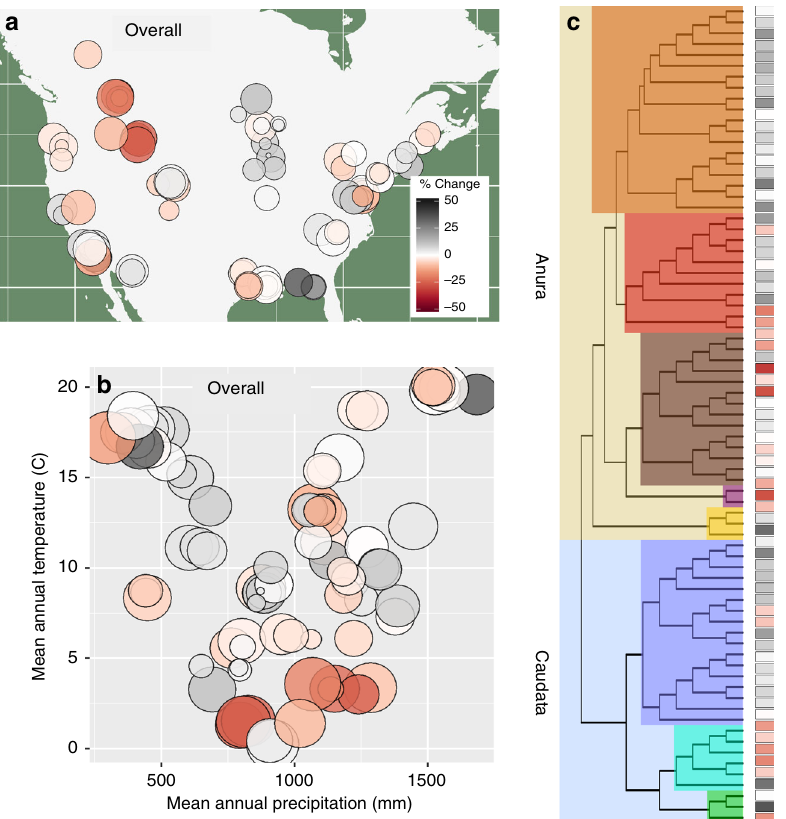
Fig. 8 Estimated effects of recent climate change on local species richness. We estimated the change in local species richness based on recent changes in mean climate from 1982 to 2012. Locations where our analysis indicates that declines were expected to have occurred are denoted using a red color scale, while areas where increases are expected to have occurred are denoted using a gray color scale. Circle sizes are proportional to the sample size for the study area (number of unique species, site, and year combinations). Values are plotted in geographic ( a ), climatic ( b ), and phylogenetic space ( c ). Expected change with respect to individual changes in each of the fi ve climate drivers is shown in Supplementary Fig. 3. Maps used in this fi gure